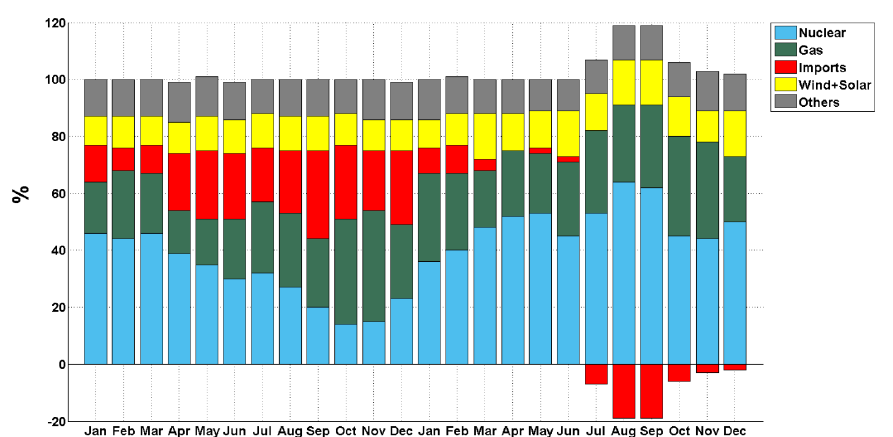
Figure 20. Monthly energy mix in the years 2018 and 2019 in Belgium